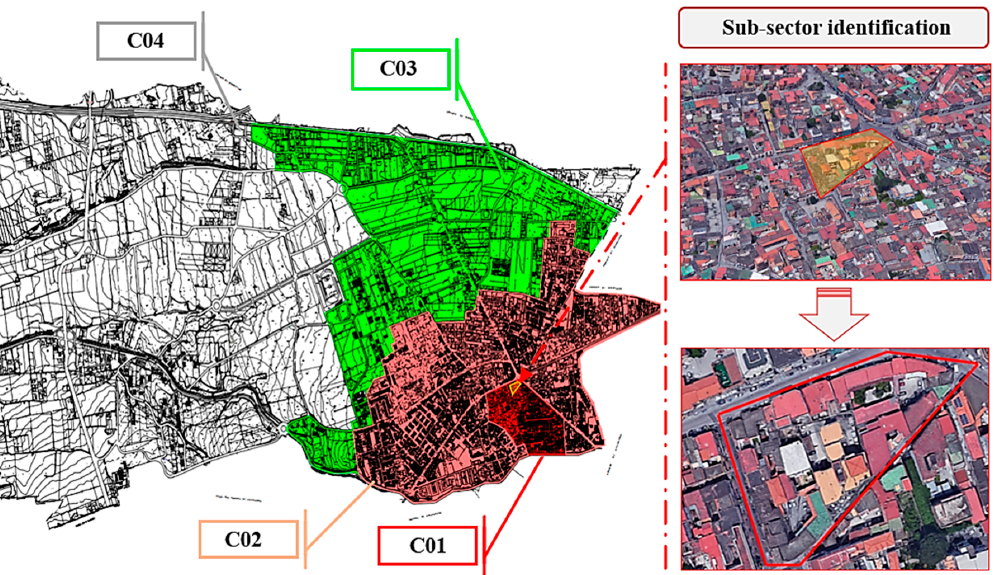
Figure 2. The main urban sectors of Qualiano.